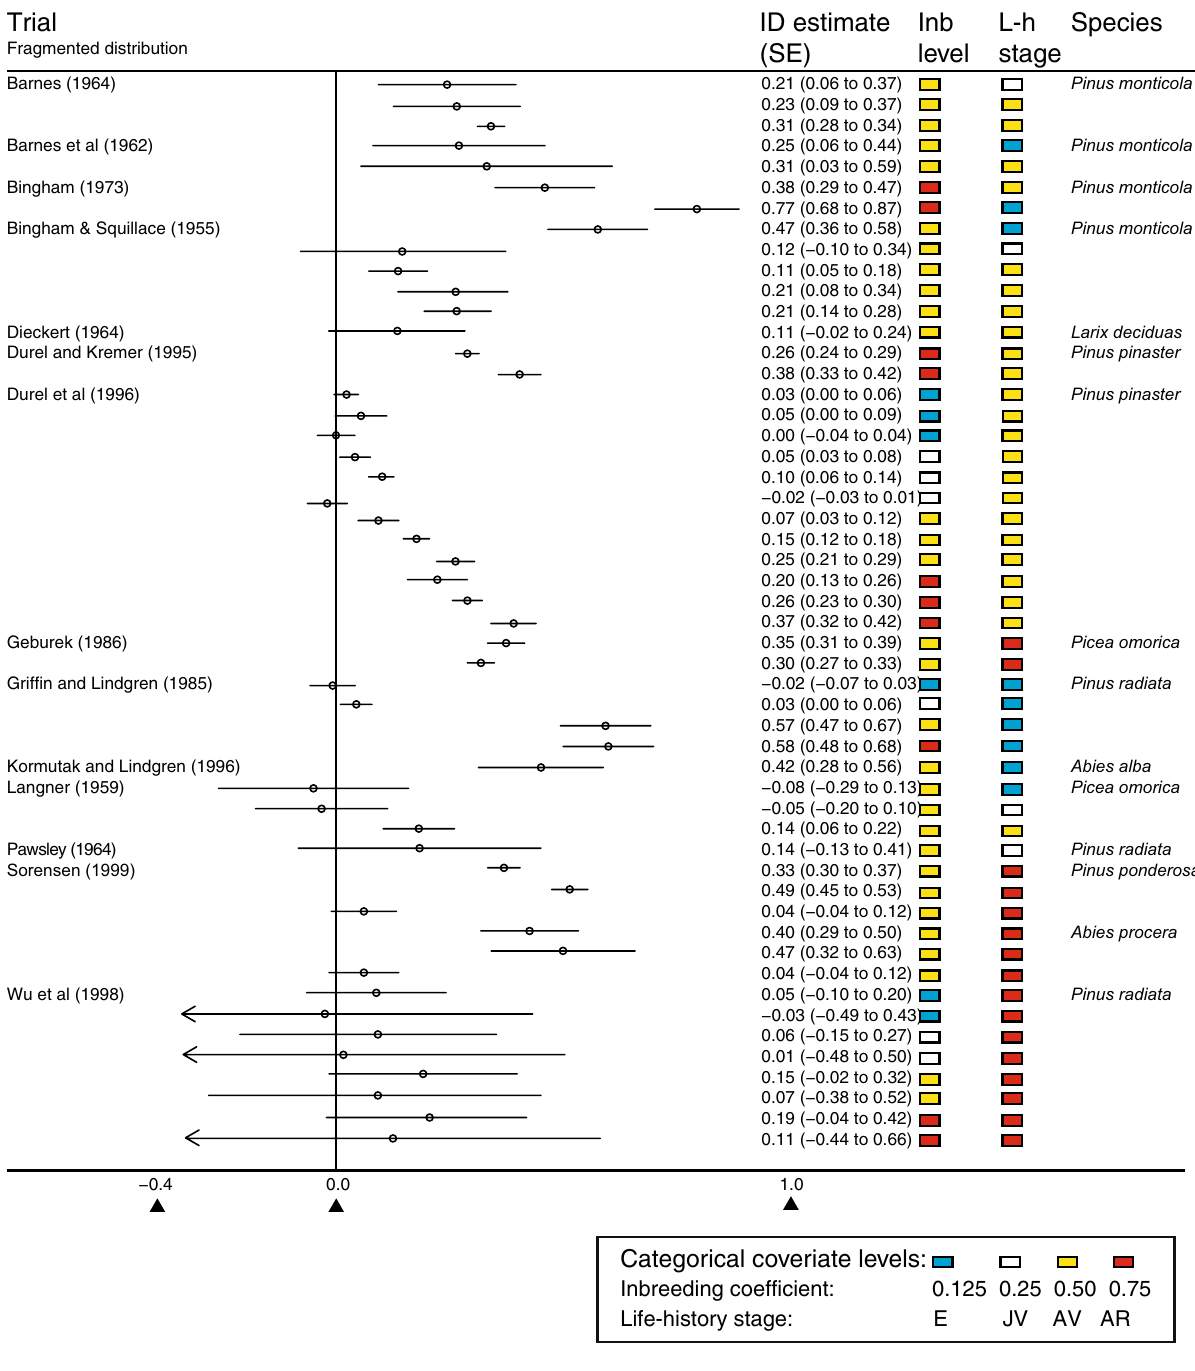
Figure 1. Forest plot of the final dataset including study-specific covariate levels for species with fragmented population distributions. The x-axis shows the level of ID. Life stage and Inbreeding are abbreviated as L-h and